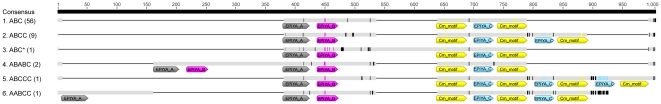
Scheme of the alignment of the EPIYA motifs with number of observations in Mexican and Venezuelan populations.